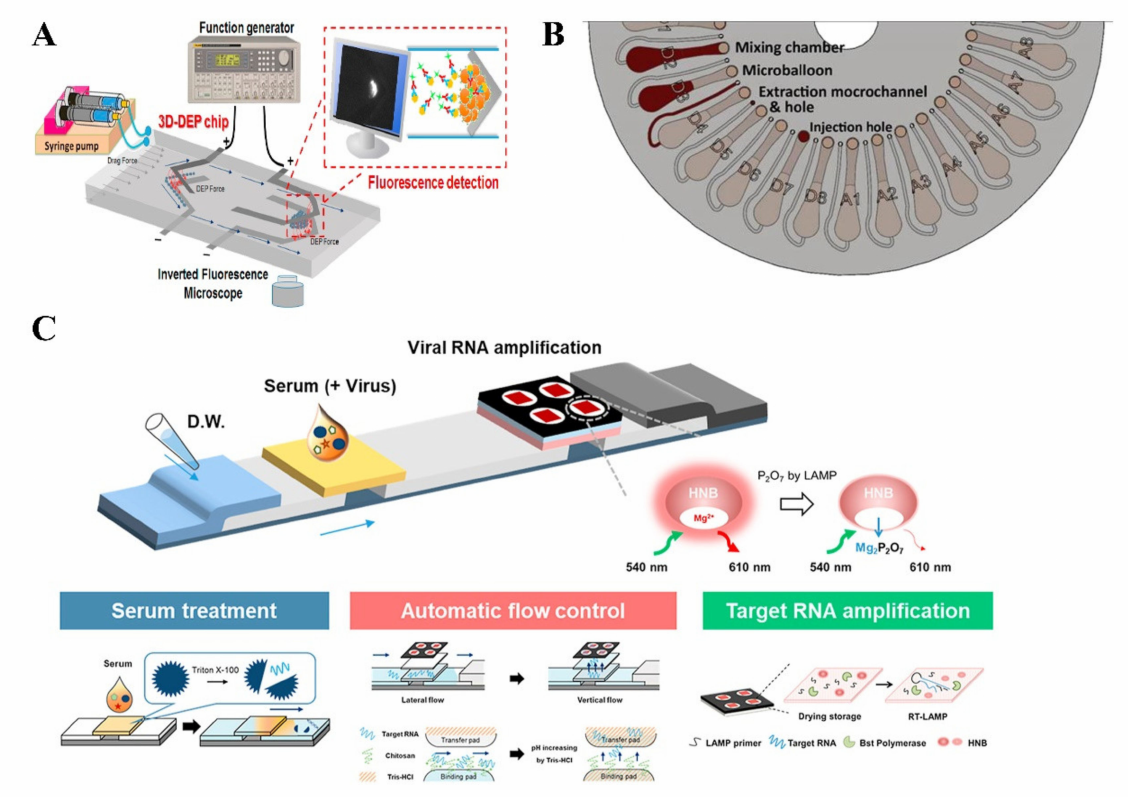
Figure 7. Detection of DENV using microfluidic-based sensing technologies. ( A ) Experimental setup of a microfluidic chip based DENV detection using dielectrophoresis technique. AC voltage was supplied by a waveform generator and inverted microscope was used to record the fluorescence of the captured virus (Reprinted with permission from ref. [179]. Copyright 2017 Elsevier.) ( B ) A multilayered and PMMA made lab on a disc microfluidic device to ensure ultrasensitive detection of DENV (Reprinted from [185]). ( C ) Lab on a paper device to detect multiple pathogen targets accommodating amplification of RNA using LAMP method (Reprinted with permission from ref. [191]. Copyright 2020